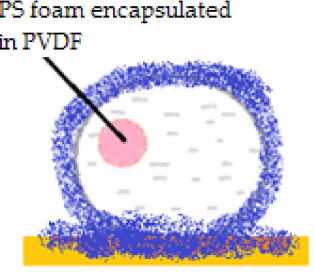
Figure 7. “Sandwich” liquid marble including PS foam covered in